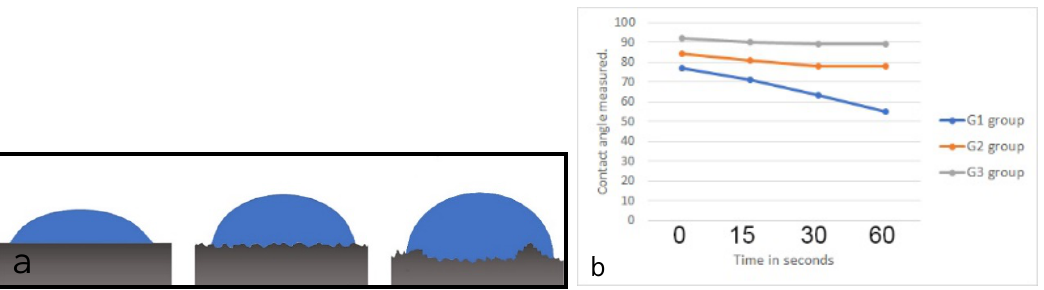
Figure 6. Scheme of the drop behavior on the surface of each group ( a ) and the bar graph of the drop dispersion after the four observation times ( b ).